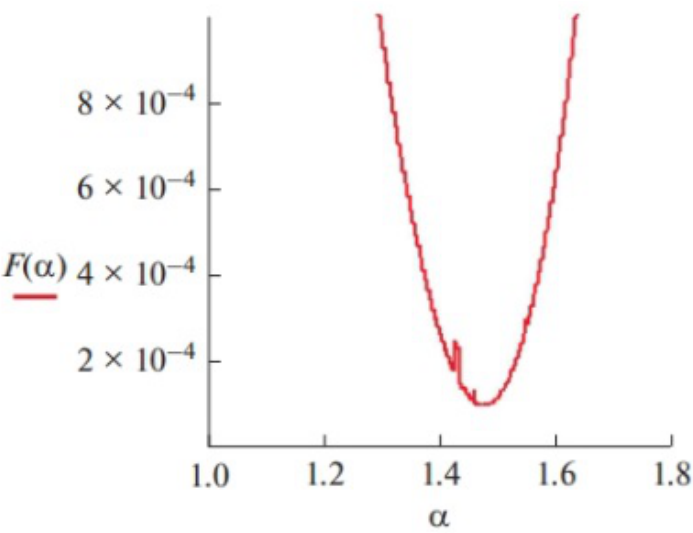
Table 1. Experimental points for polymer concrete samples